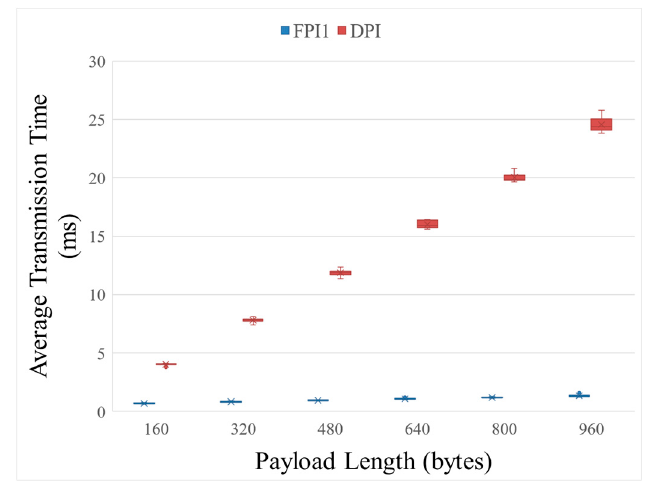
Figure 5. Comparison of packet transmission times of FPI and DPI.